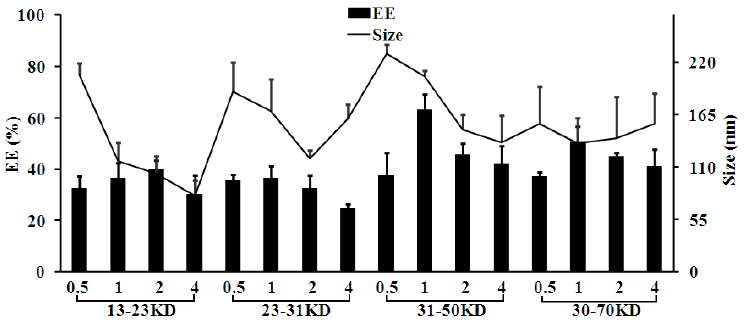
Figure 5. The effect of PVA on the entrapment efficiency (EE) and size of Sal-LPNPs (mean ± SD, n = 3). PVA molecular weight and concentration were shown on the X axis.